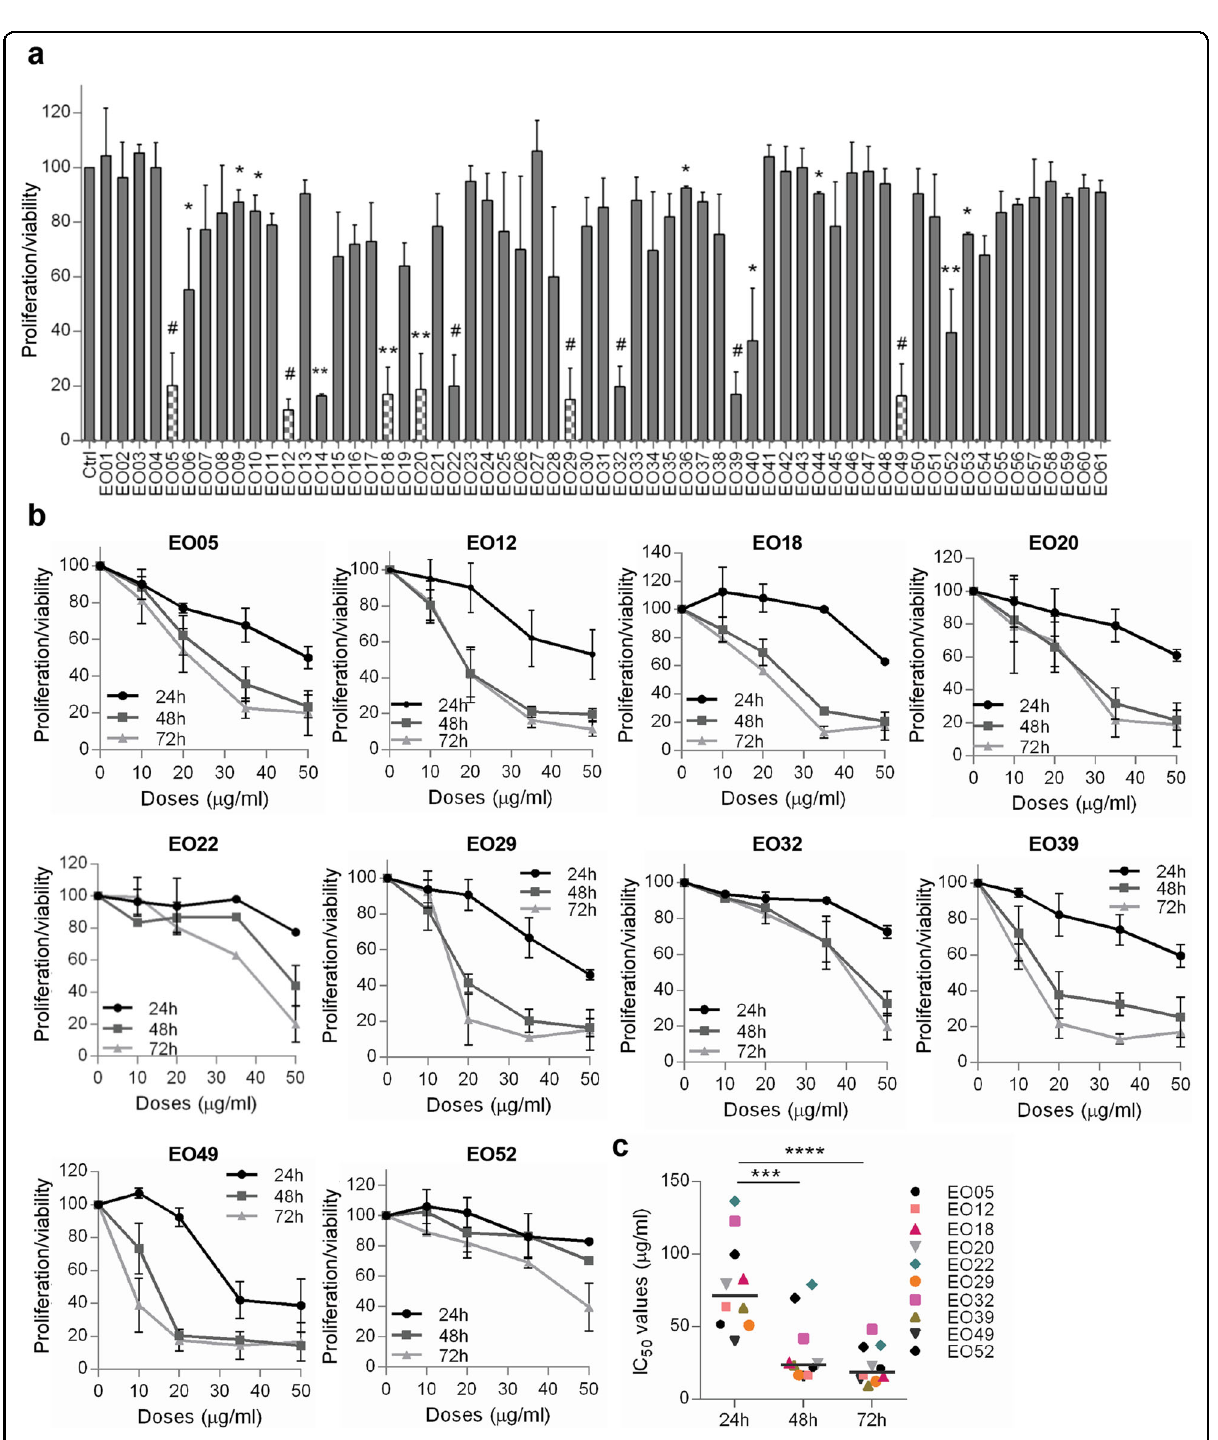
Fig. 1 M14 cells are differentially sensitive to a panel of EOs. a Analysis of cell proliferation/viability by MTT assay of M14 cells treated with 61 essential oils (EOs, EO01-EO61, 50 μ g/ml, 72 h). p- values were calculated between control (Ctrl) and EO-treated cells. * p < 0.05; ** p < 0.01; # p < 0.001 after applying Student ’ s t test. Dotted columns represent the six EOs further investigated in this study. b MTT assay of M14 cells treated with the indicated EOs (10 – 50 μ g/ml, 24 – 72 h). a , b Results are reported as “ cell proliferation-viability of treated cells/cell proliferation-viability of control cells × 100 ” and represent the average±standard deviation of at least three independent experiments. c Quanti fi cation of 50% inhibition of cell proliferation/ viability (IC 50 ) of the indicated EOs calculated for M14 cells treated as reported in b . The median of IC 50 is shown. *** p < 0.001; **** p < 0.0001 after applying one-way ANOVA